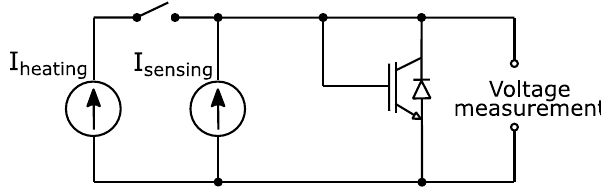
Figure 5. Threshold (MOS diode) mode power-cycling setup.